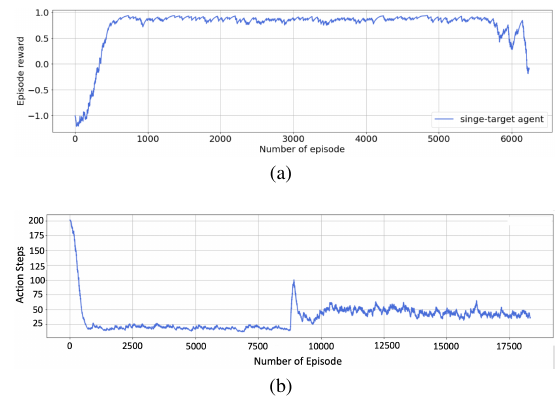
Figure 6. Number of steps taken for 100 test episodes and the Figure 8. (a) Training curves tracking the agent’s episode reward resulting trajectories generated for visualization for the while closing one road at a time. (b) Training curves tracking the multi-target agent. agent’s episode steps while closing roads